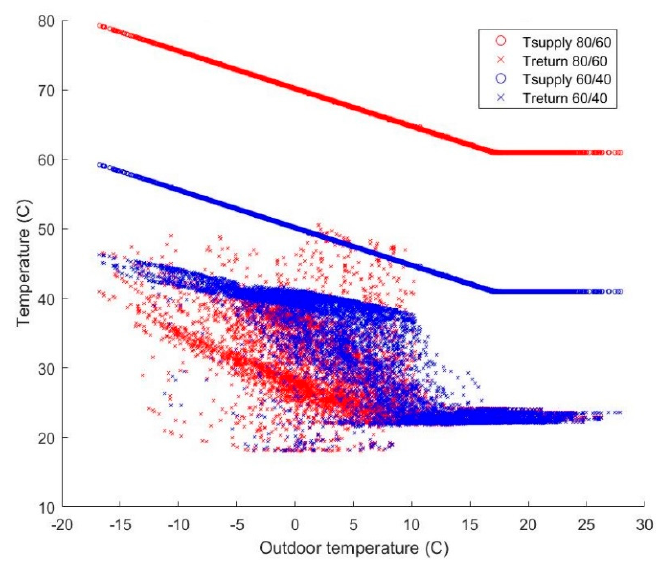
Figure 3. Radiator supply and return temperatures relative to outdoor temperature for AB_03 as-